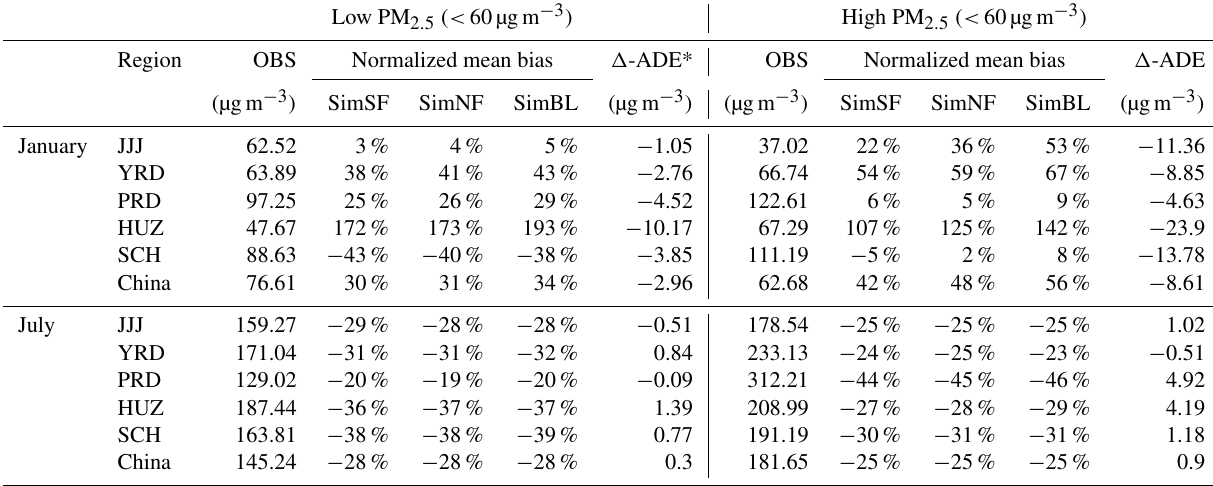
Table 2. Comparison of model performance in ozone prediction across three simulations (monthly average of daily 1h maxima).